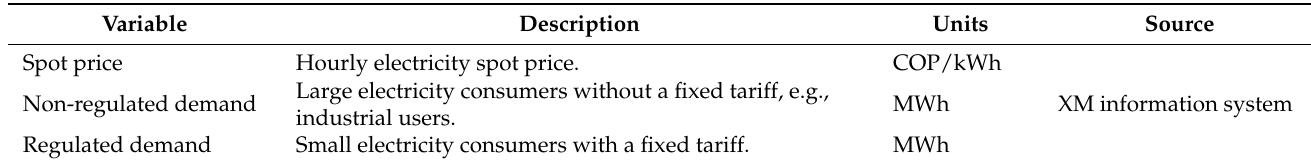
Table 1. Data description.